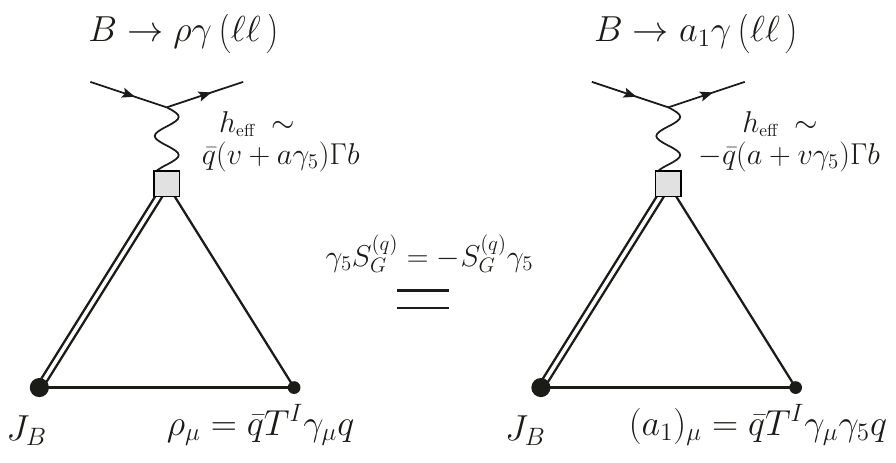
Figure 1 . Diagram representing the procedure outlined in the text, using the relation (2.12), which necessitates both the limits m q 0 and (cid:22) qq 0 in (2.7). The argument only requires ! h i ! that the weak vertex h e(cid:11) be a local operator, and thus applies to both SD (form-factor) and LD (charm-loop) contributions. Note that the argument also applies to the annihilation topology where the photon is emitted from the b -quark or light-quark lines in the triangle graph. The schematic correlation functions on the left and right are exactly equal, from where the information on the matrix elements can be assessed via the LSZ formalism or dispersion relations, when taking into account (cid:12)nite-width e(cid:11)ects. Corrections to this exact equality, beyond the chiral symmetry limit, are discussed in section